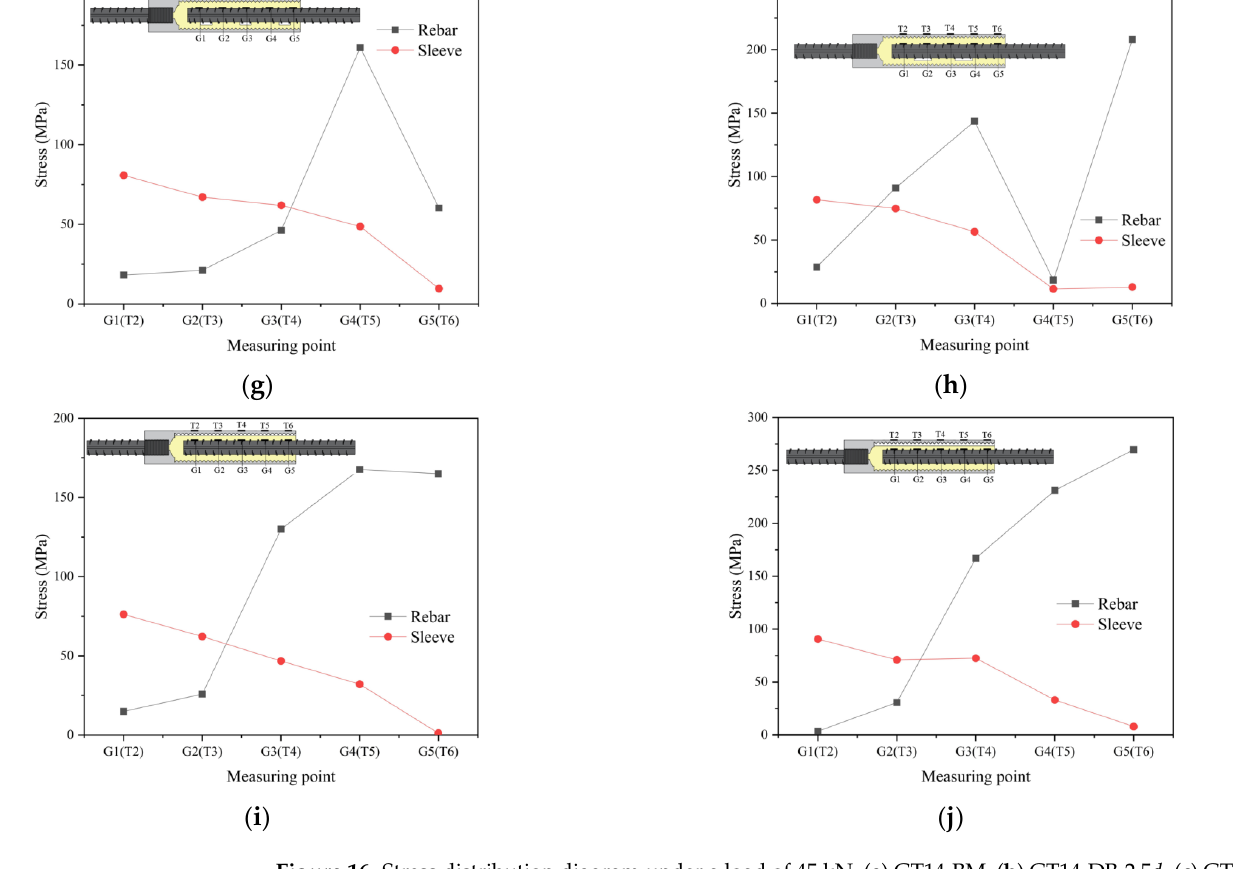
Figure 16. Stress distribution diagram under a load of 45 kN. ( a ) GT14-BM. ( b ) GT14-DB-2.5 d. ( c ) GT14-DB-3 d. ( d ) GT14-ZB-2.5 d. ( e ) GT14-JB-3-2.5 d. ( f ) GT14-JB-2-2.5 d. ( g ) GT14-DC-3-2.5 d. ( h ) GT14-DC-2-2.5 d. ( i ) GT14-SP-2mm. ( j ) GT14-SP-4mm.